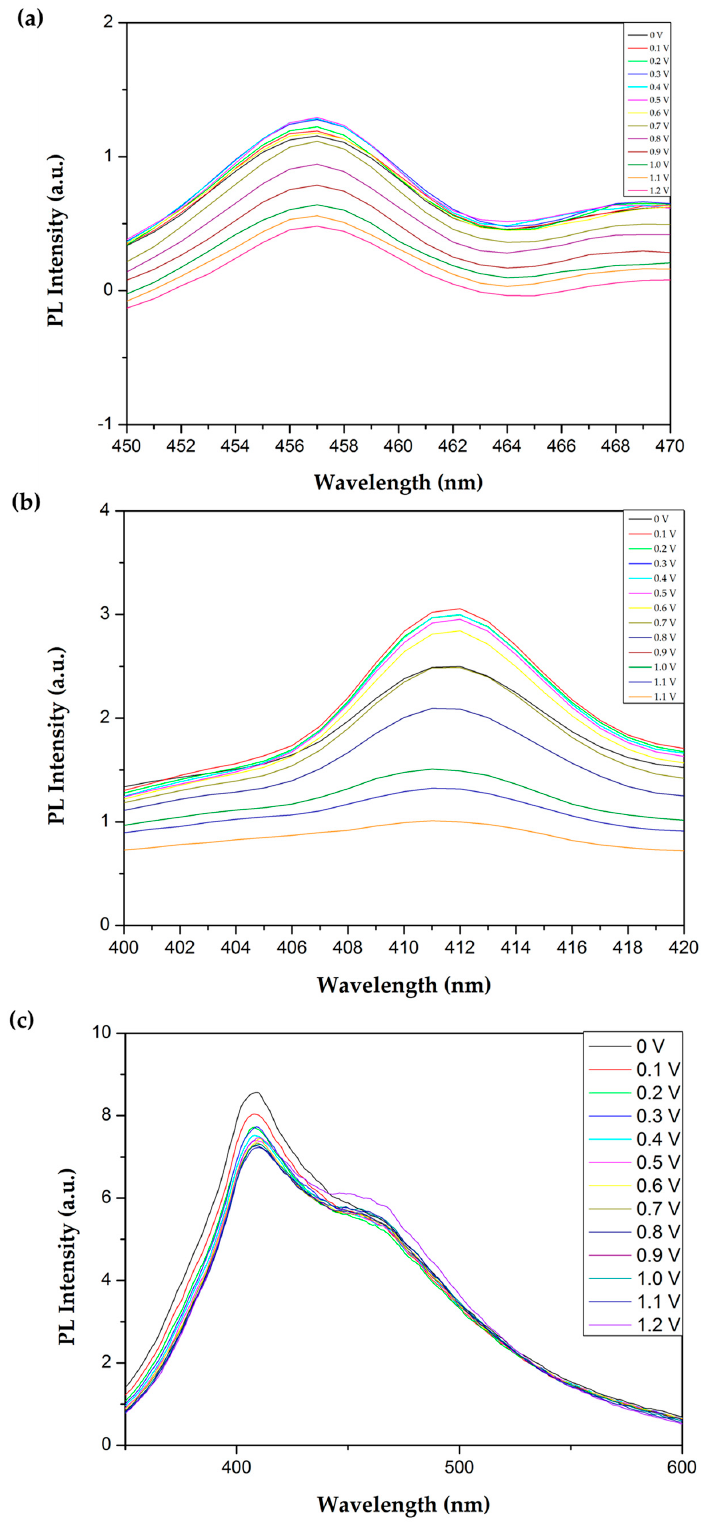
Figure A12. Fluorescence spectra changes of PA–b ( a ); PA–c ( b ); and PA–d ( c ) film upon different applied potentials from 0.0 to 1.2 V.